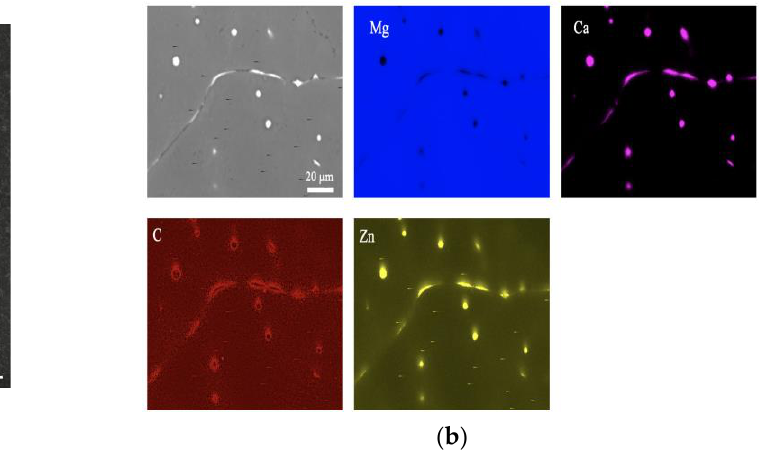
Figure 7. EDS analysis of the ZX10-2ND nanocomposite. ( a ) SEM micrograph of ZX10-2ND with magnification of the intermetallic particle shown in the middle including EDS analysis on two points and ( b ) EDS elemental mapping of Mg, Ca, C, and Zn performed on the left micrograph in the upper row.